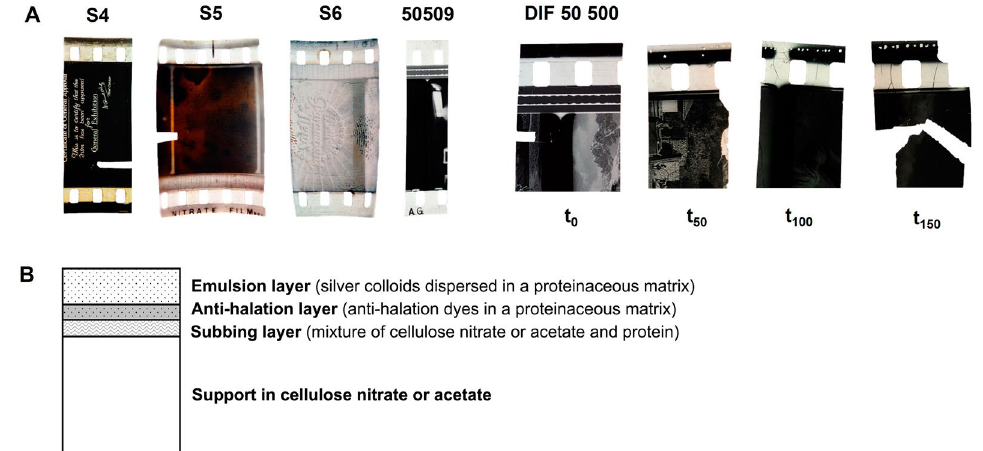
Figure 2. ( A ) Cinematographic film samples S4, S5, S6, 50 509 and DIF 50 500. DIF 50 500 was artificially aged (λ ≥ 280 nm, 40 °C): at 50 h of irradiation the film was yellowed and fragile; at 100 h presented cracking; and at 150 h the film lost its integrity. ( B ) Multi-layer structure of a generic cinematographic film. The cellulose nitrate is the thickest layer and it is the support of the image. The image is formed by silver colloids dispersed in a proteinaceous matrix which is adhered to the support by another thin layer, the subbing layer. Finally, the anti- halation layer prevents light to be reflected in the image layer causing a halo